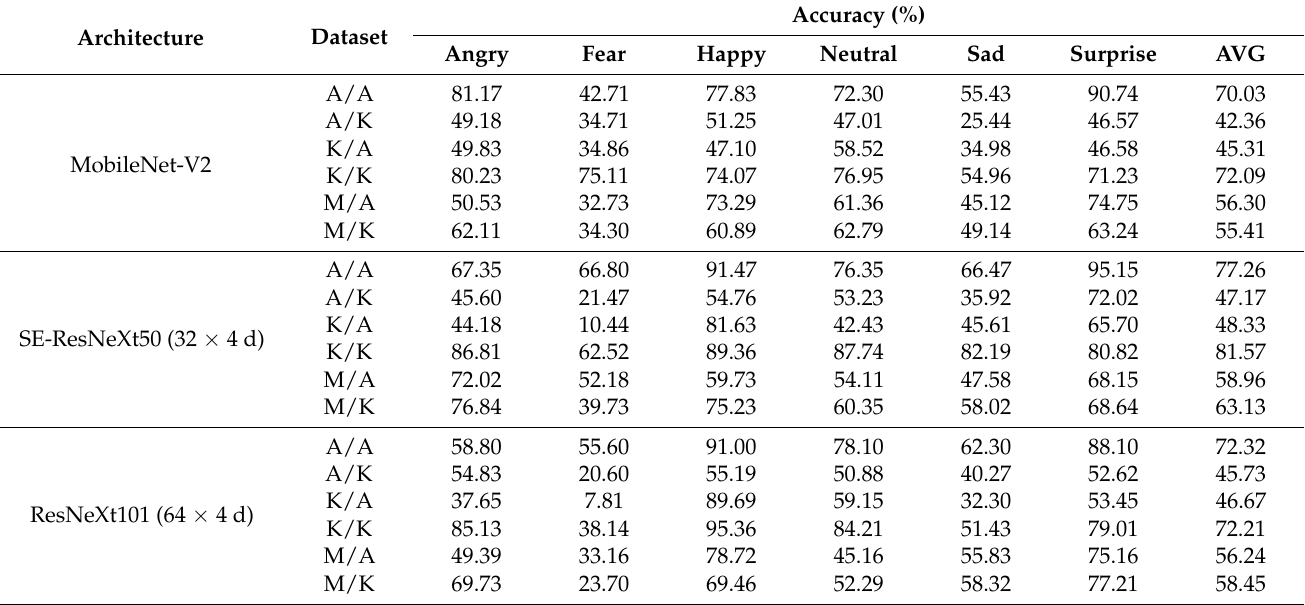
Figure 7. ResNeXt101 (64 × 4 d)’s accuracy according to different emotions: ( a ) angry, ( b ) fear, ( c ) happy, ( d ) neutral, ( e ) sad, ( f ) surprise. Table 4. Recognition accuracy of each emotion for all